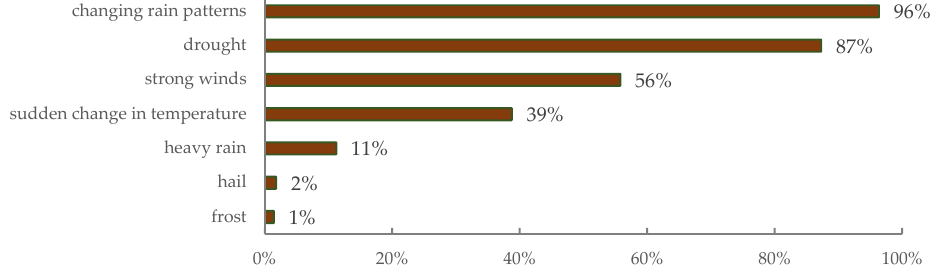
Figure 7. Perception of the phenomena that most impact production (Source: prepared by the authors).